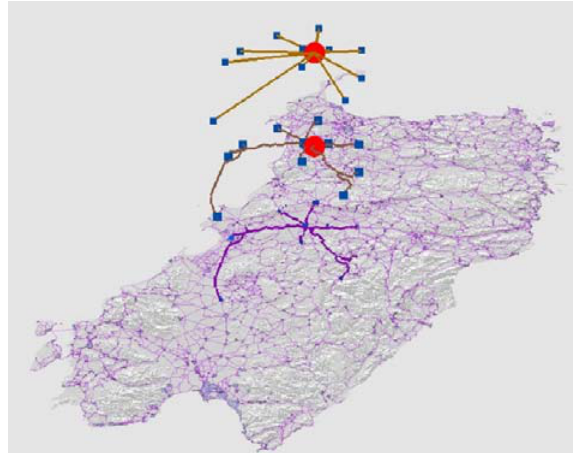
Figure 1. 3D visualisation of Sardinia. On the background the road-ways used by the commuters of the town of Soddì are highlighted, while the Euclidean distance is drawn on the top and the shortest road distance is floating in the middle (De Montis et al.,